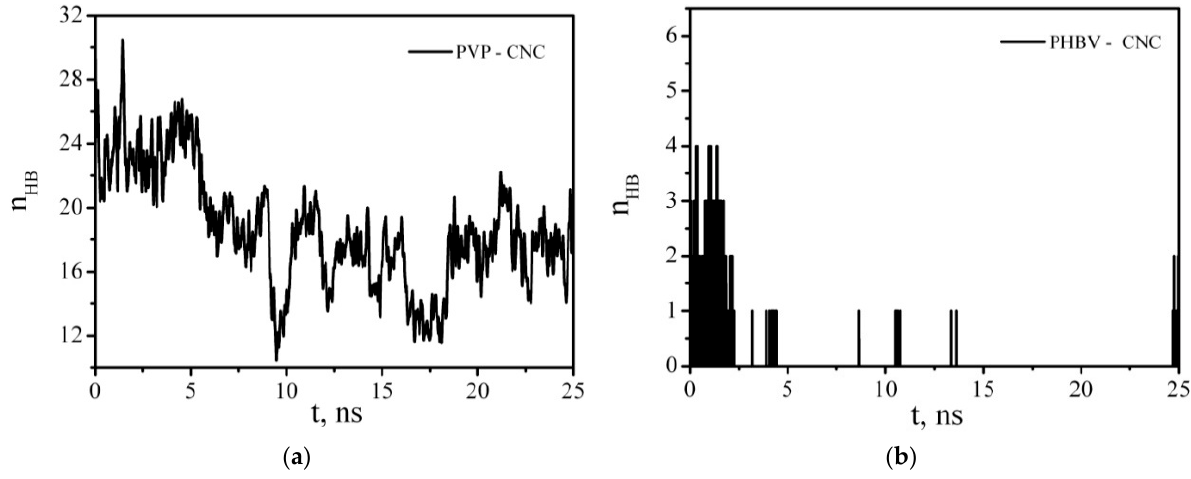
Figure 19. Time dependence of the number of PVP–CNC ( a ) and PHBV–CNC ( b ) hydrogen bonds.